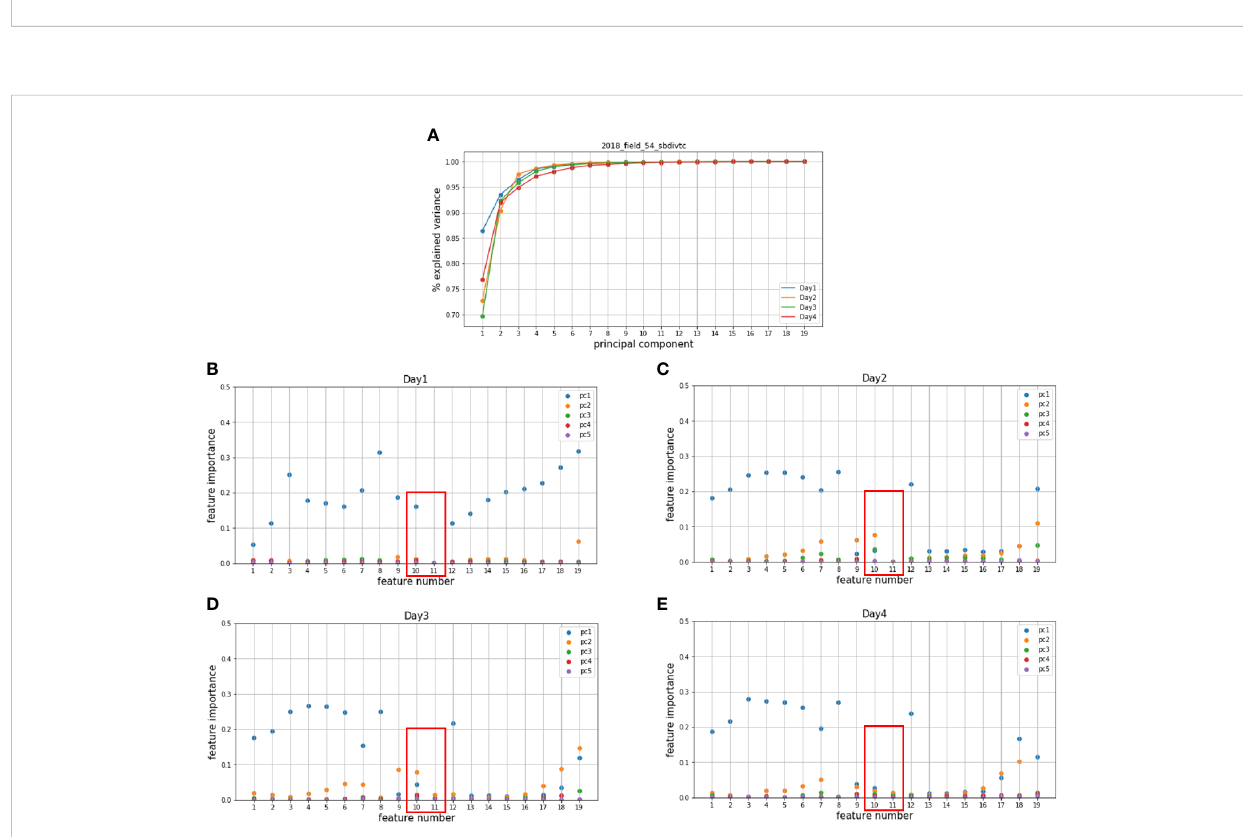
FIGURE 7 Principal components of the LiDAR features in (A) 2018 Tc panel and the corresponding importance of all LiDAR features on (B) 1st, (C) 2nd, (D) 3rd, (E) 4th dates which represents 4 different growing stages.